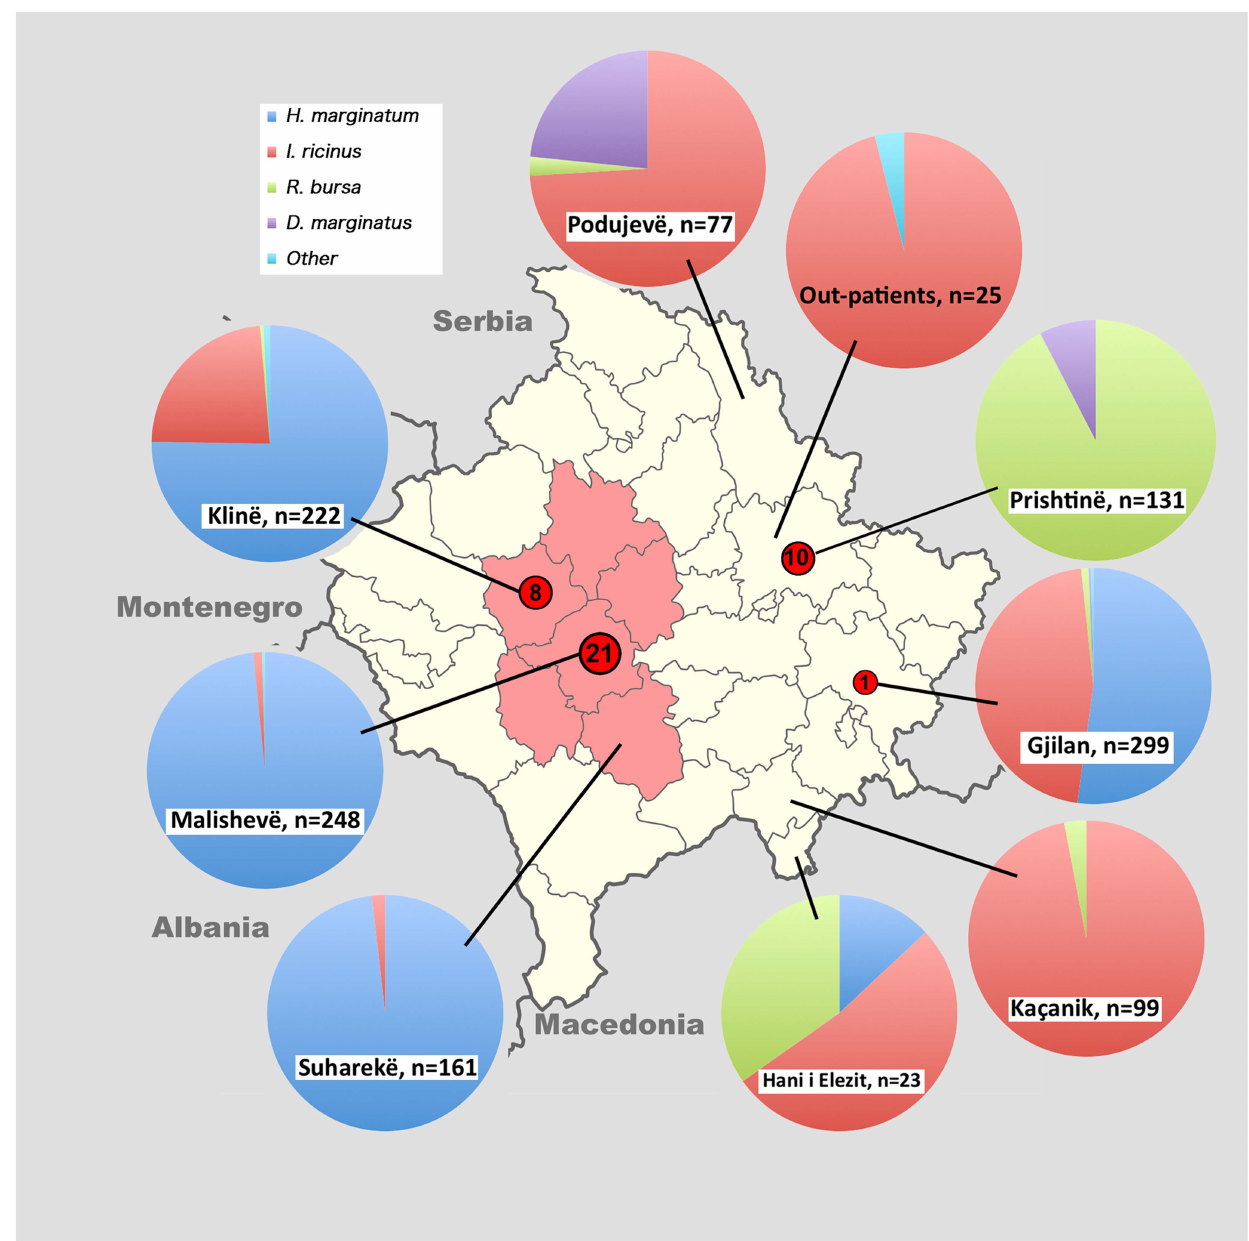
Figure 1. Ixodid tick species distribution in Kosovo, 2012. Also shown are the municipality borders. In red are the CCHF-hyper-endemic municipalities according to Jameson et al. (2012). The numbers in the red circles indicate virus-positive tick